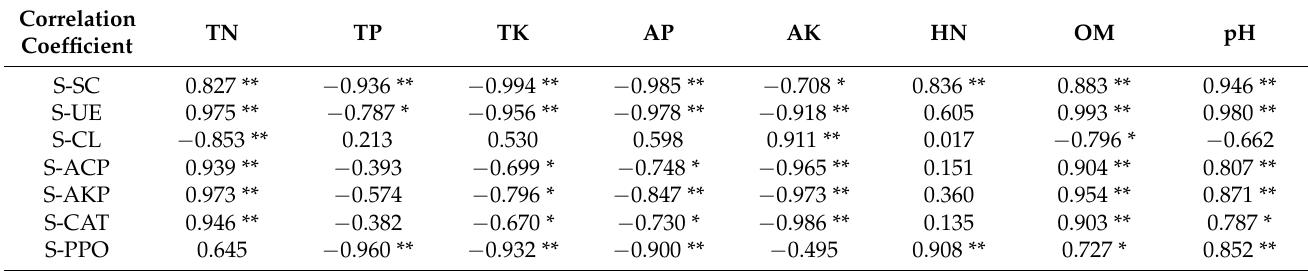
Table 5. Correlation analysis between soil physicochemical properties and enzyme activities in three soil samples.